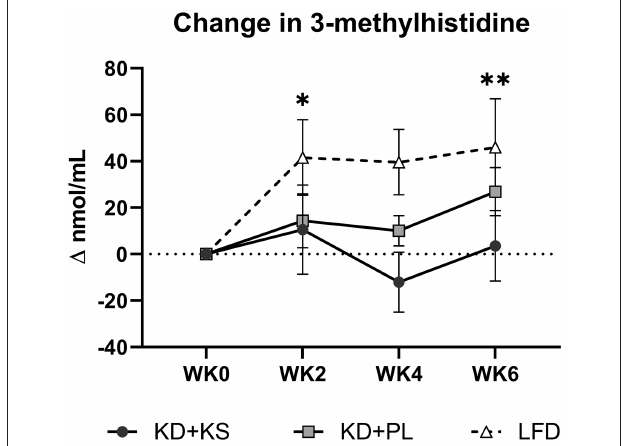
FIGURE 4 | Change in normalized plasma 3-methylhistidine relative to baseline. Values were subtracted from WK0 plasma 3MH concentrations and analyzed for significant covariance effects. Primary statistic: 2 (group) × 4 (time) ANOVA with normalized baseline held as covariate. No significant effects were detected between KD groups. With LFD included in the secondary 3 (group) × 4 (time) ANOVA – Time effect: * p < 0.05; ** p < 0.01 from